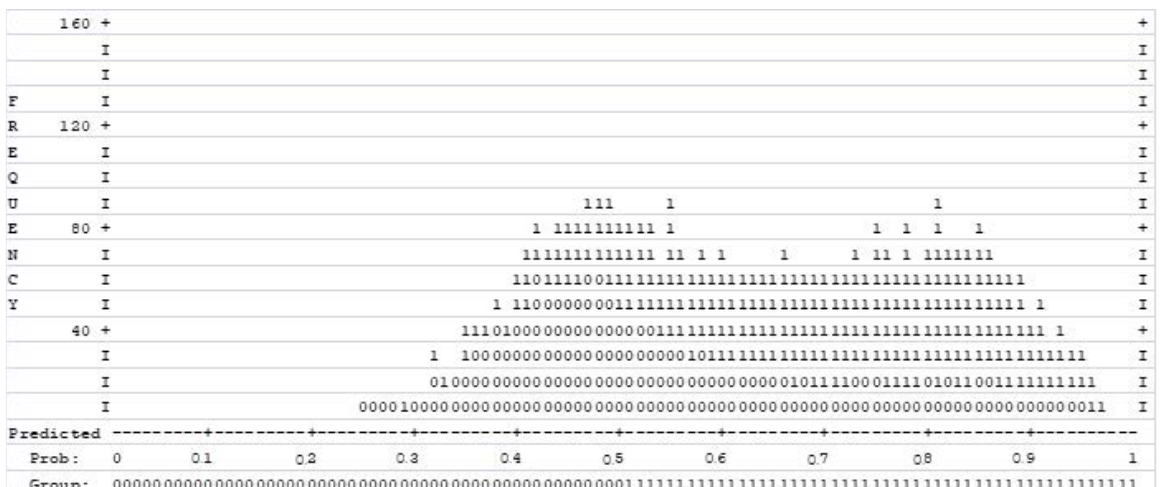
Figure 5. Classification plot showing the accuracy of the model in predicting individual cases, where each symbol (0 or 1) represent 10 cases. The symbol 1 is equal to snow melting, while 0 is equal to snow accumulation. The cut value is 0.5; values above the cut value represent melting, while for lower values there is no